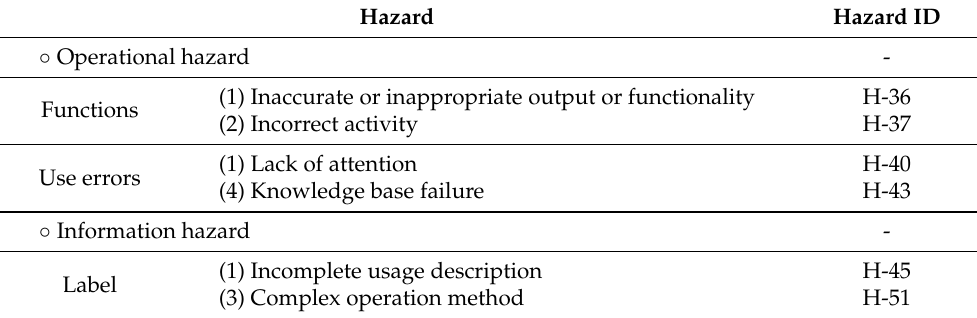
Table 1. Hazards for sinus surgical navigation system.